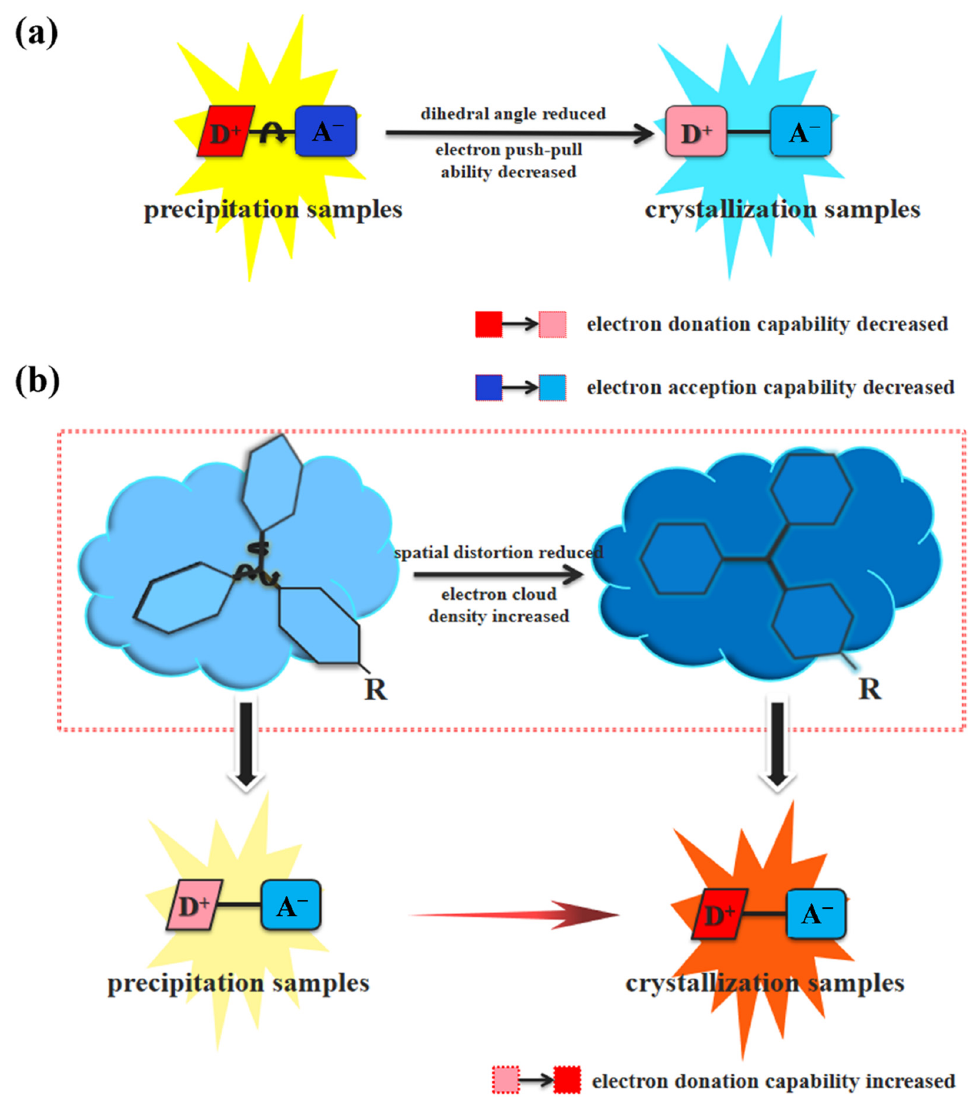
Figure 8. The multiple chromism (MC) mechanism of ( a ) PI, NI, FI and ( b ) TI. In the case of TI-C , the dihedral angle between ring A 3 and ring B 3 is 34.70° (Figure FI are closely related to the J/X aggregation modes caused by the distorted